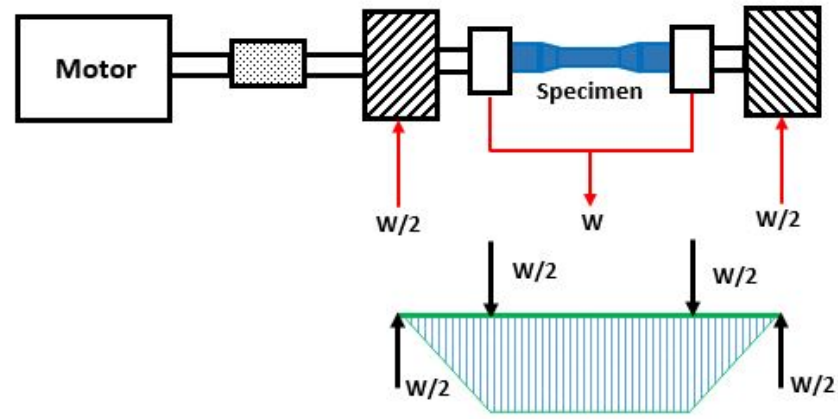
Figure 3. Four-point rotating bending machine.